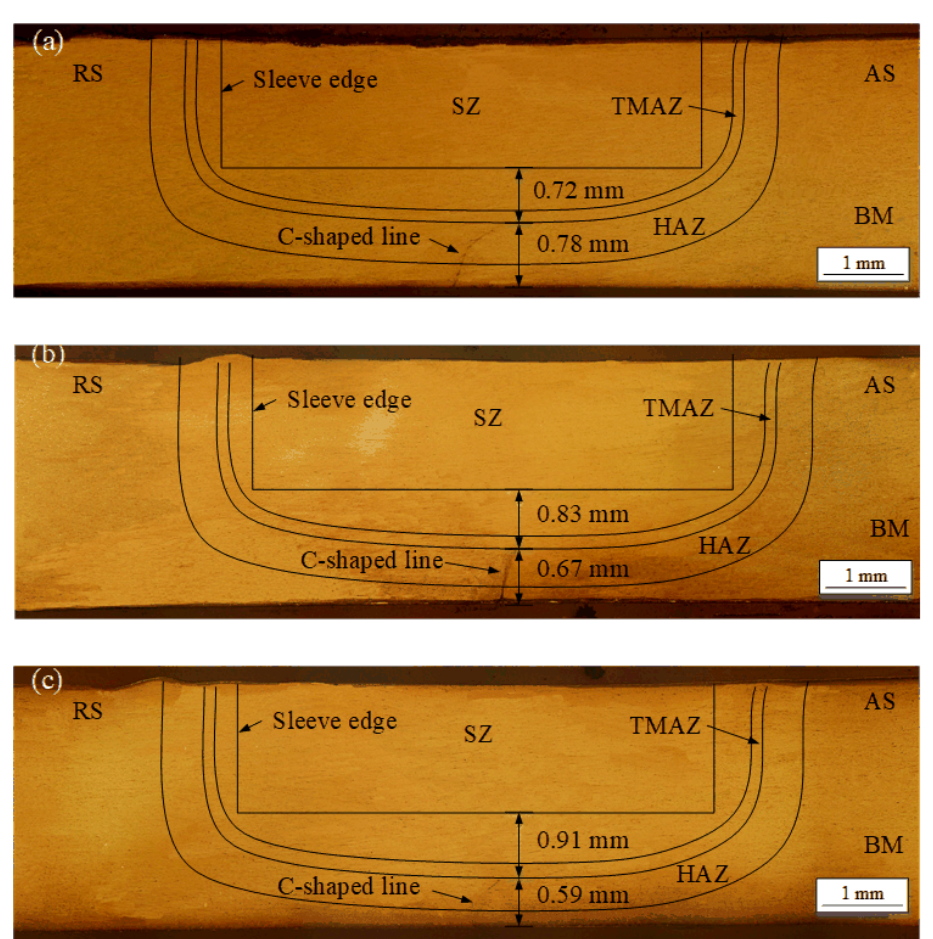
Figure 4. Cross sections of joints with ( a ) RN sleeve, ( b ) RF sleeve and ( c ) RE sleeve.